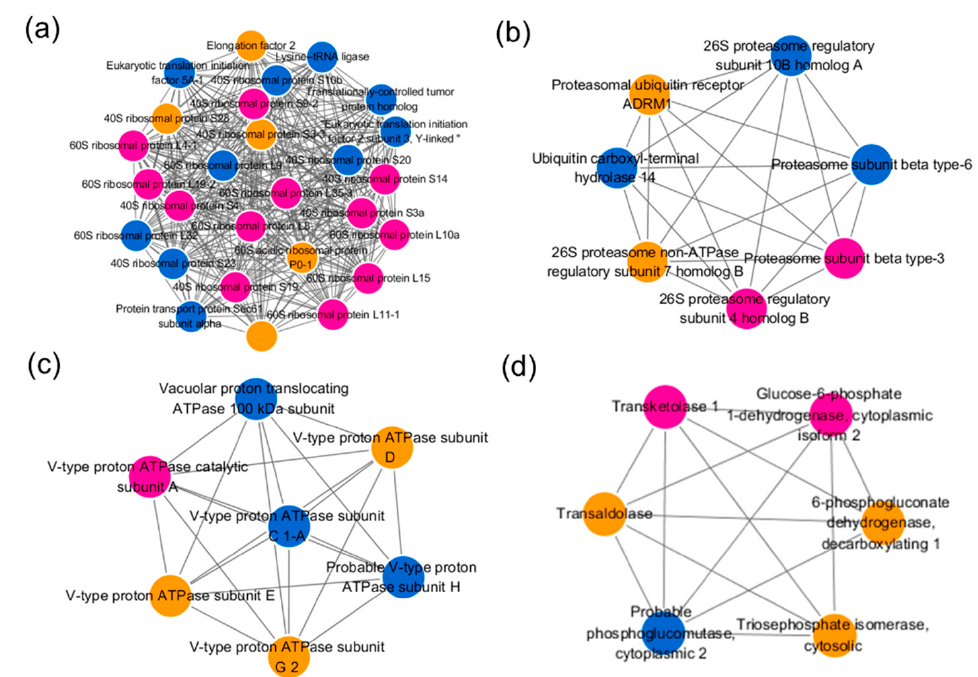
Figure 6. Interaction network of the quantified lysine ubiquitinated proteins. ( a ) The subnetwork involved in ribosome pathway; ( b ) the subnetwork involved in UPS; ( c ) the subnetwork related with V-type ATPase; ( d ) the subnetwork related with pentose phosphate pathway. The proteins in purple were upregulated and the proteins in blue were downregulated. Proteins in orange were modified at different sites with both increased and decreased levels.